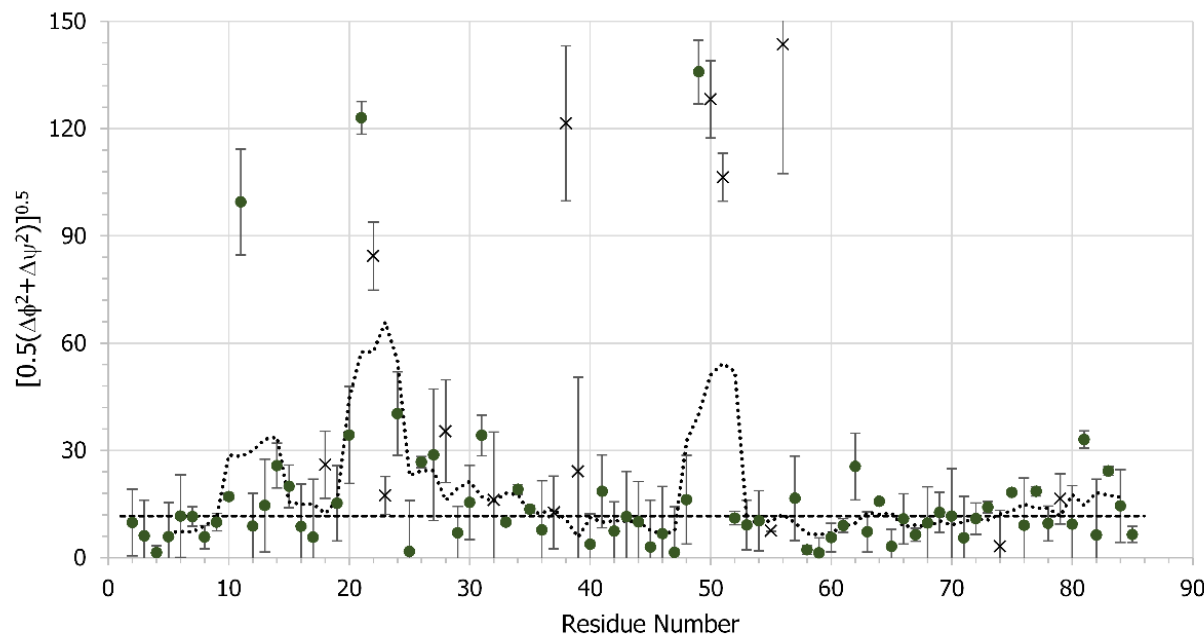
Figure 10. Quadratic average of the backbone torsion-angle differences Δ𝜙 = 𝜙 𝑓𝑟𝑒𝑒 − 𝜙 𝑏𝑜𝑢𝑛𝑑 and Δ𝜓 = 𝜓 𝑓𝑟𝑒𝑒 − 𝜓 𝑏𝑜𝑢𝑛𝑑 , given by √0.5(Δ𝜙 2 + Δ𝜓 2 ) , between the free and ssDNA-bound gVp. Predictions with low reliability in TALOS are marked with ‘x’. The dashed line represents the average of all entries having values < 30 degrees and equals 11.6 degrees. The dotted line is the 5-point moving average.